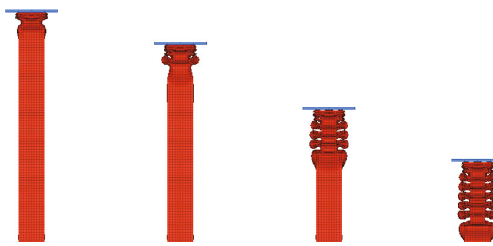
Figure 19: The deformation history of designed tube with circumferential